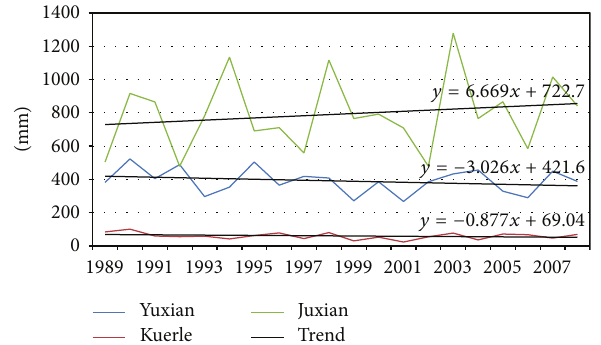
Figure 9: Moisture index at the selected weather stations from 1989 to 2008.